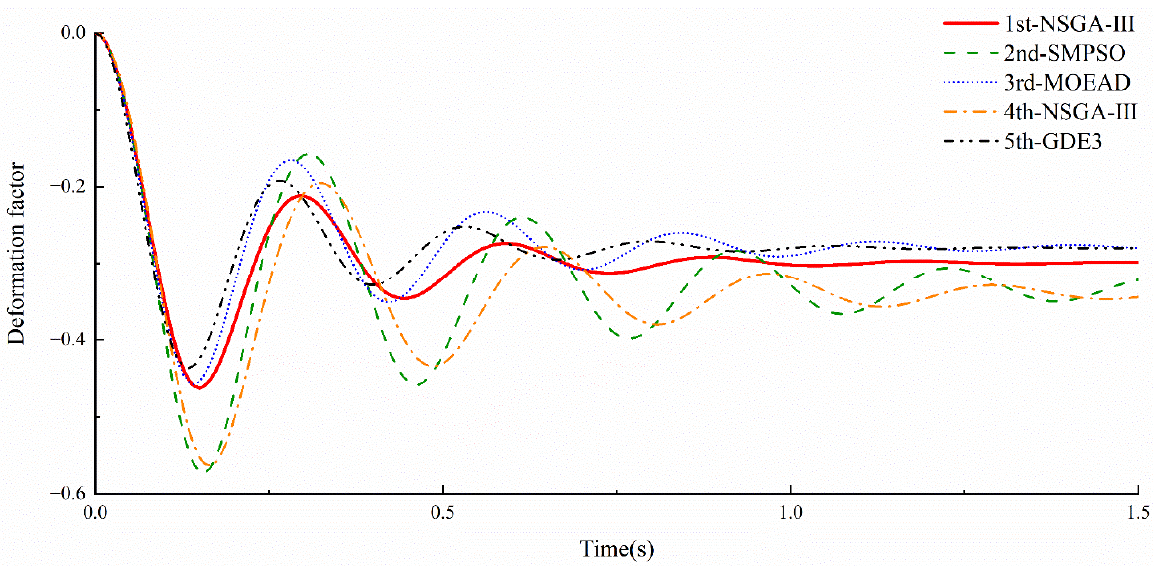
Figure 6. The quarter suspension modal spring deformation factor time response curve.